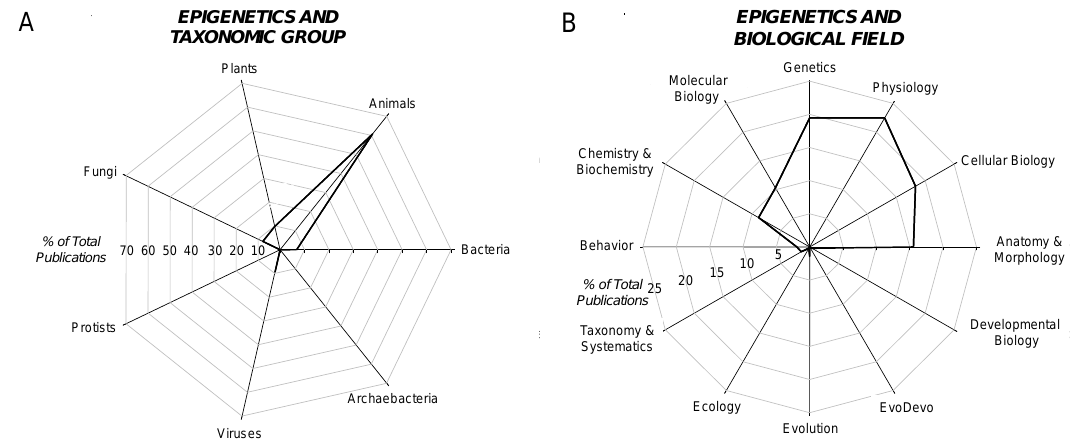
Figure 2. Radar diagram showing the relative distribution of publications on epigenetics drawn from the PubMed database (http://www.ncbi.nlm.nih.gov/pubmed/). ( A ) distribution of publications that contain the search terms “epigenetic(s)” and one of seven biological taxa; ( B ) distribution of publications that contain the search terms “epigenetic(s)” and one of 12 biological fields.